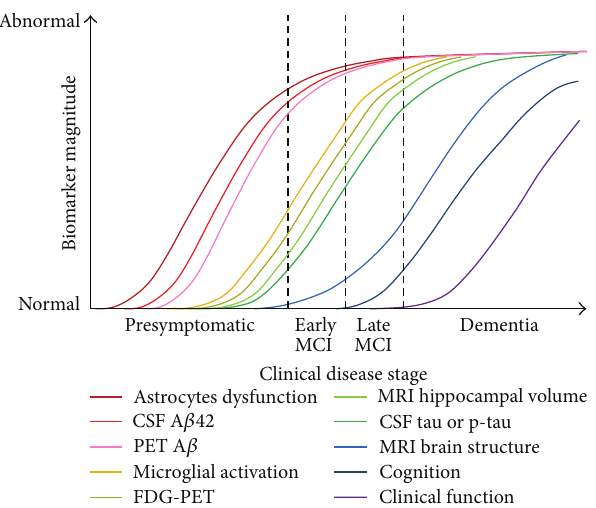
Figure 2: Chronobiological biomarkers to Alzheimer’s disease clinical stage. This illustration is reproduced with permission from [91] and adapted from figures after [87, 101,